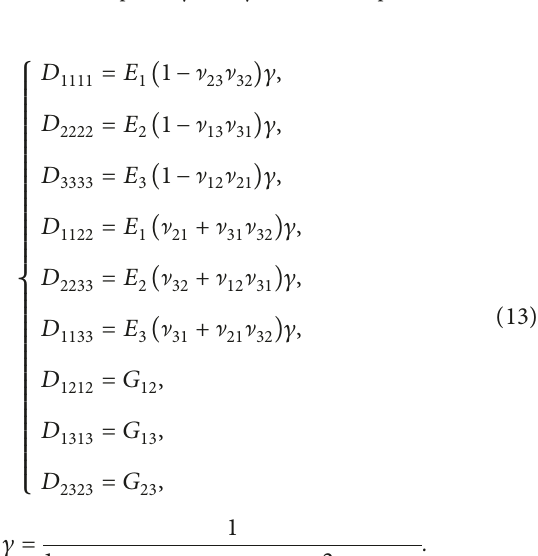
Figure 5: Superalloy honeycomb MTPS panel [21].